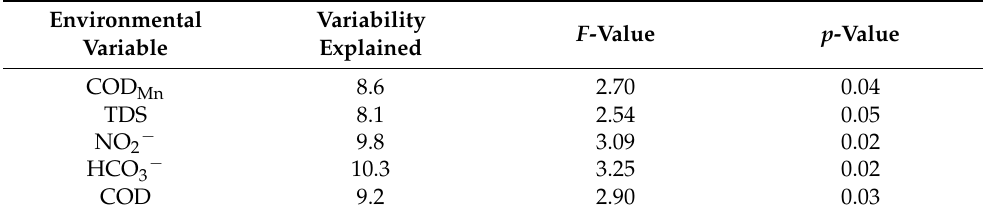
and higher NO 2 − and COD, but was independent from COD Mn and TDS. The saprobic index was strongly related to HCO 3 − . Table 6. Ranking of environmental variables that significantly influenced the phytoplankton community structure based on the Monte Carlo permutation test in CCA.